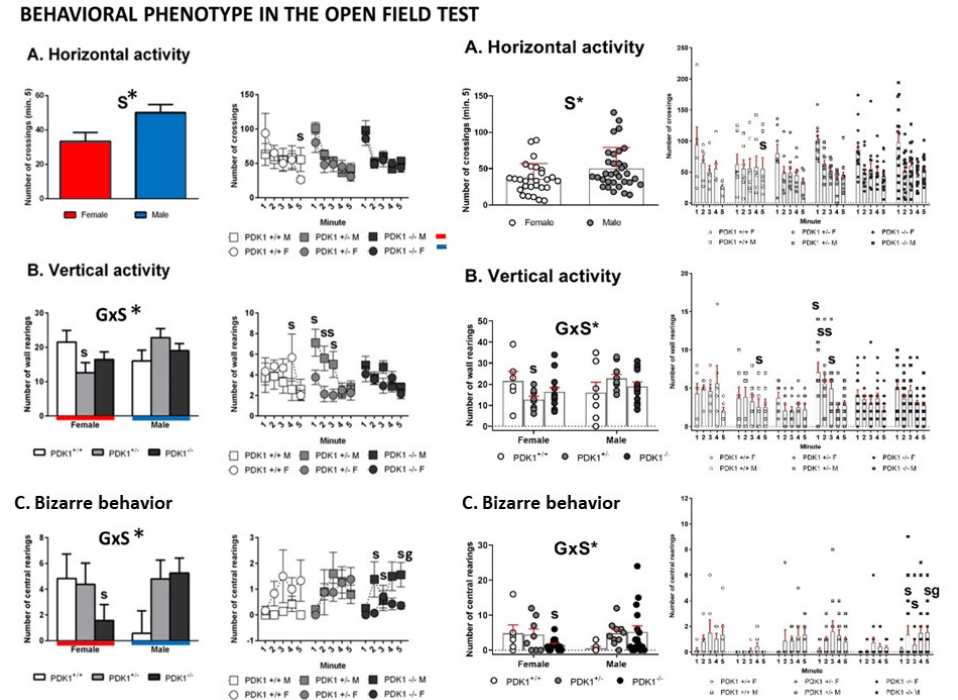
Figure 4. Exploratory and bizarre behaviors in the open-field test in female and male mature PDK1 − / − , heterozygous PDK1 +/ − and homozygous WT (PDK1 +/+ ) mice. (( A – C ) Left panel ): Data are expressed as mean ± SEM or incidence. (( A – C ) Right panel ): Individual data are depicted. Bars illustrate the genotype groups, as indicated in the Y-axis. Symbols illustrate the different groups (left panel) or individual values (right panel), as depicted in the legends or abscissae. Factorial analysis: G, genotype effect; S, sex effect, * p < 0.05. Post hoc test: g (genotype), g p < 0.05 vs. the corresponding WT (PDK1 +/+ ) group; s (sex), s p < 0.05, ss p < 0.01 vs. the corresponding male of the same genotype.